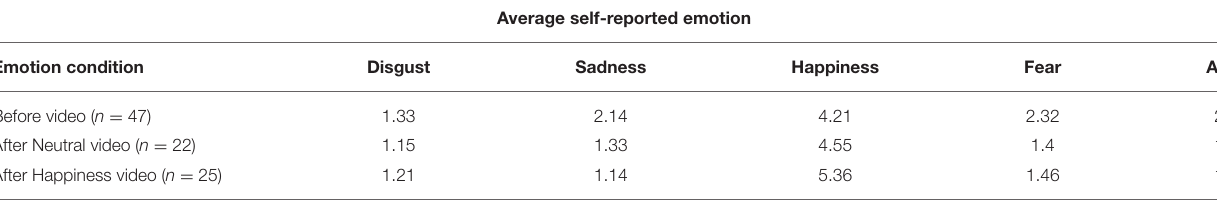
TABLE 1 | Manipulation check: average self-reported emotional states on a scale of 1–7, before and after viewing the videos. Average self-reported emotion Emotion condition Disgust Sadness